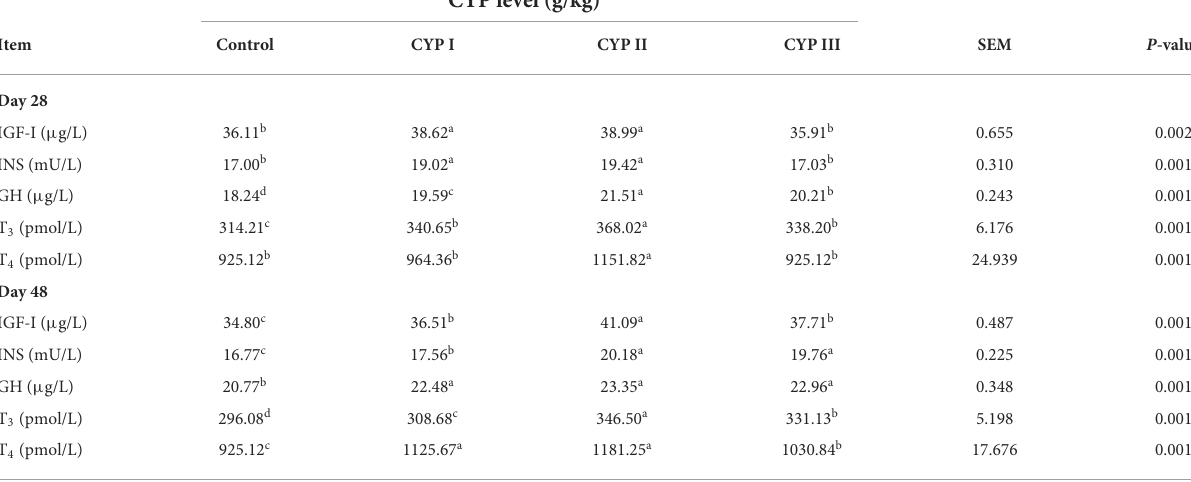
TABLE 4 Effects of CYP on the serum biochemical indicators in broilers.